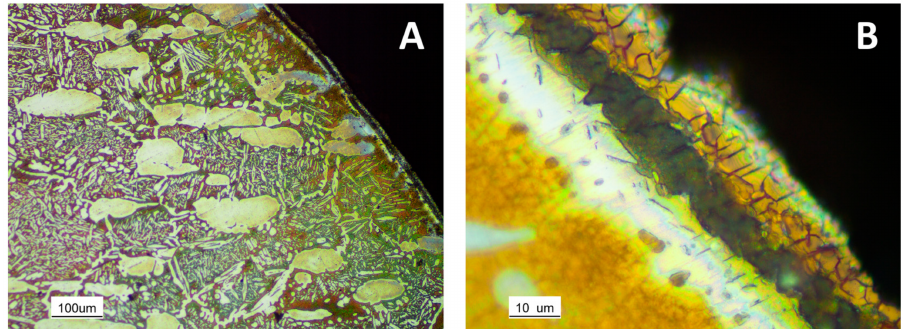
Figure 5. Ferrite-rich external layer given by aluminum diffusion ( A ); and surficial aluminum-rich layers and intermetallic precipitates ( B ) of the sample thermally annealed at 1080 ◦ C for 360 s/mm and hot-dip aluminized at 1100 ◦ C for 2700 s.